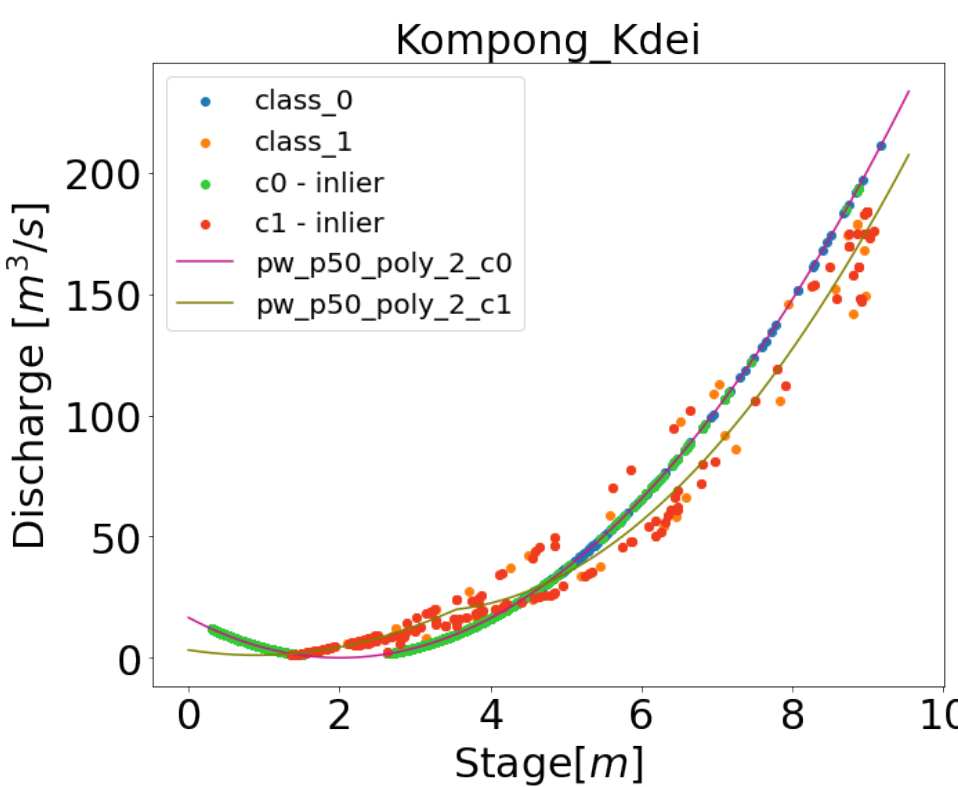
Figure 10. Figure shows the clusters (represented by class_0 and class_1 ) and result of outlier de- tection (represented as c0-inlier and c1-inlier ). The fitting of the polynomials are represented as pw_p50_poly_2_c1 and pw_p50_poly_2_c0